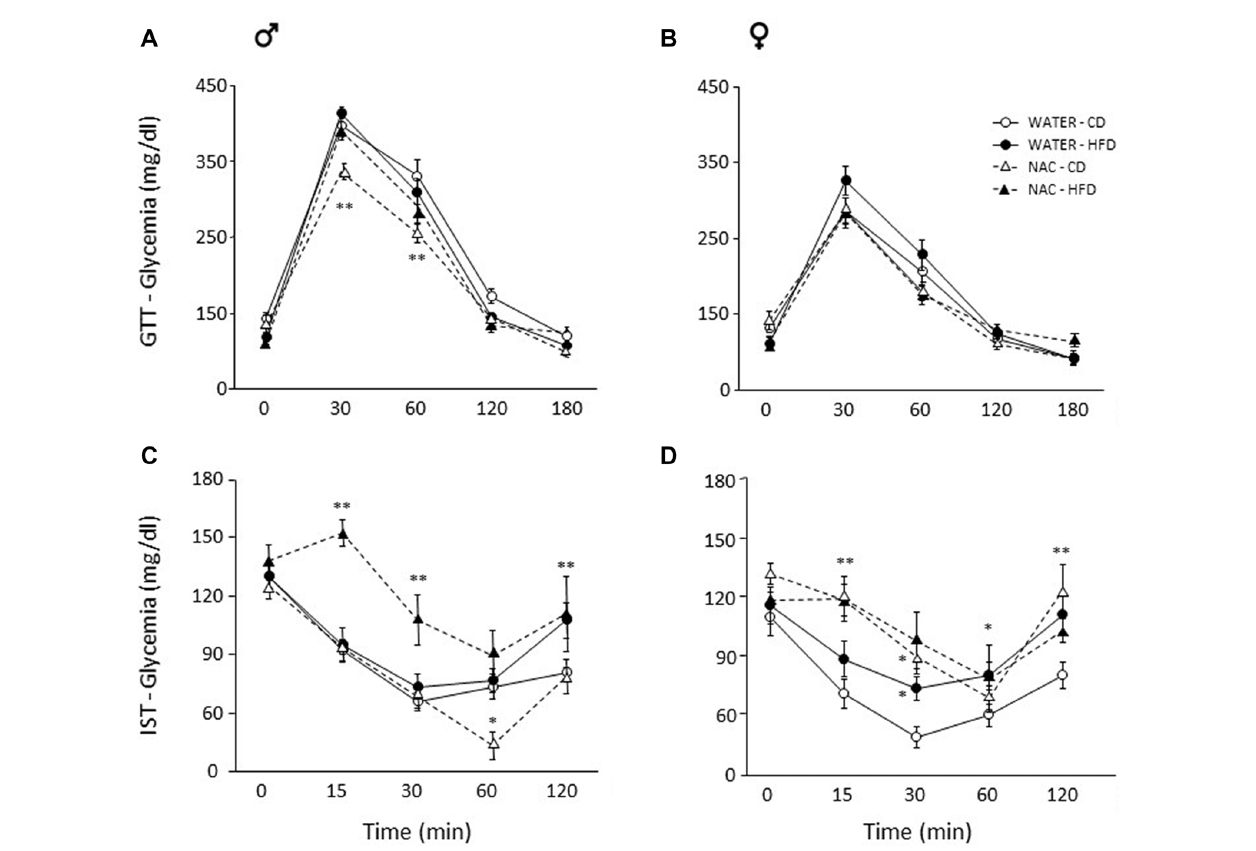
FIGURE 3 | Glucose tolerance test (GTT) and insulin sensitivity test (IST). Glucose tolerance: (A) NAC-CD males were characterized by improved glucose tolerance particularly 30 and 60 min following glucose loading. (B) No difference was found among treatment groups in females. Insulin sensitivity: (C) Interestingly, NAC-CD males showed improved insulin sensitivity 60 min following insulin injection. By contrast, the NAC-HFD subjects showed an overt worsening of the glycaemic profile. (D) Females showed a glycaemic profile comparable to that of NAC-HFD comparable males as a result of NAC alone. Data are mean ± SEM; ∗∗ p < 0.01: (A) NAC-CD vs. all other treatment groups at time points 30 and 60. (C) NAC-HFD vs. all other treatment groups at time points 15 and 30; WATER-HFD and NAC-HFD vs. WATER-CD and NAC-CD at time point 120; (D) NAC-CD vs. WATER-CD at 15 and 120 min. ∗ p < 0.05: (C) , NAC-CD vs. all other treatment groups at time point 60; (D) , NAC-CD and WATER-HFD vs. WATER-CD at time point 30; WATER-HFD vs. WATER-CD at time point